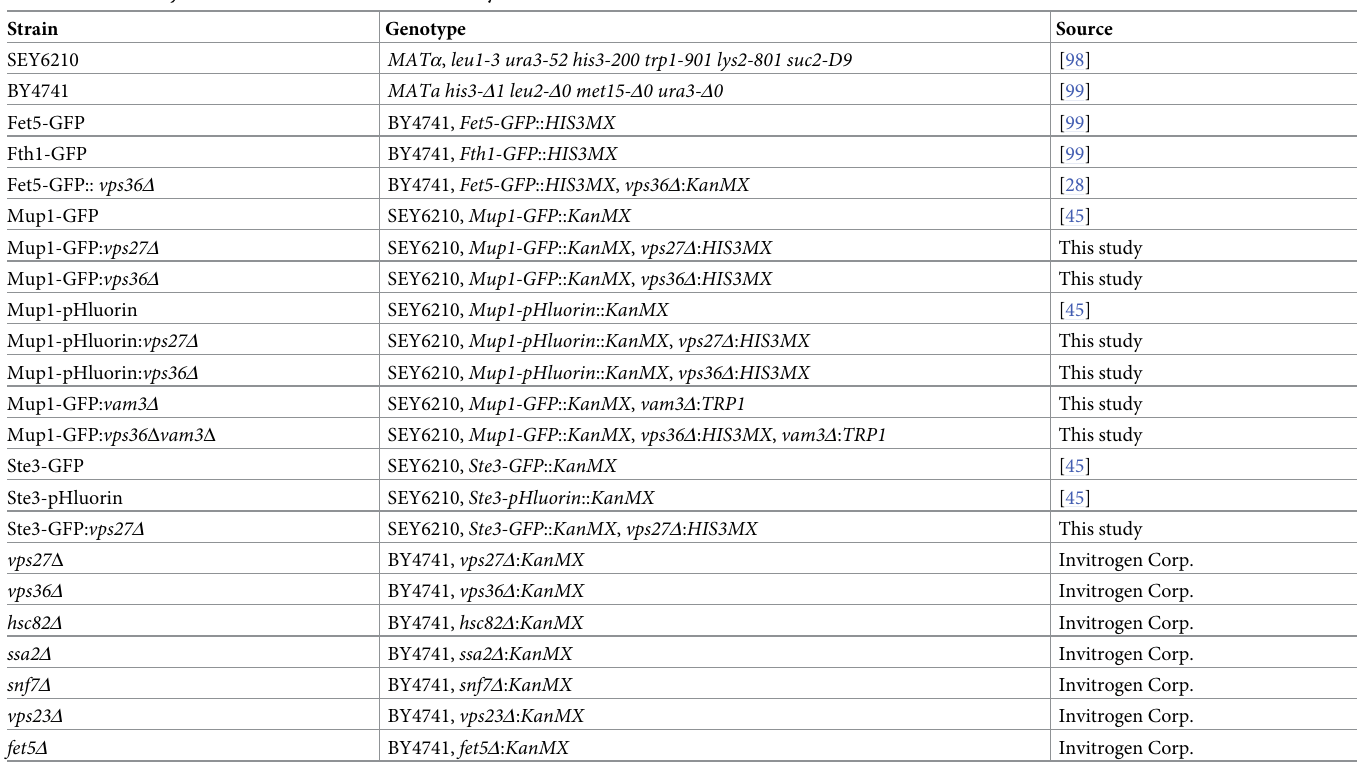
Table 1. Saccharomyces cerevisiae strains used in this